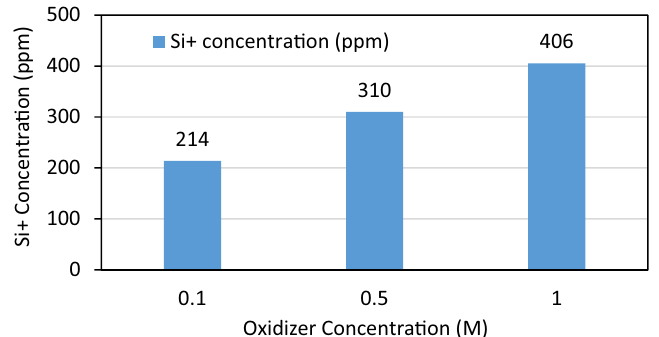
Figure 4. The ICP-OES results for analyzing the effluent of the reaction of the stated chemical mixtures at different oxidizer concentrations with Barite-Quartz filter cake.